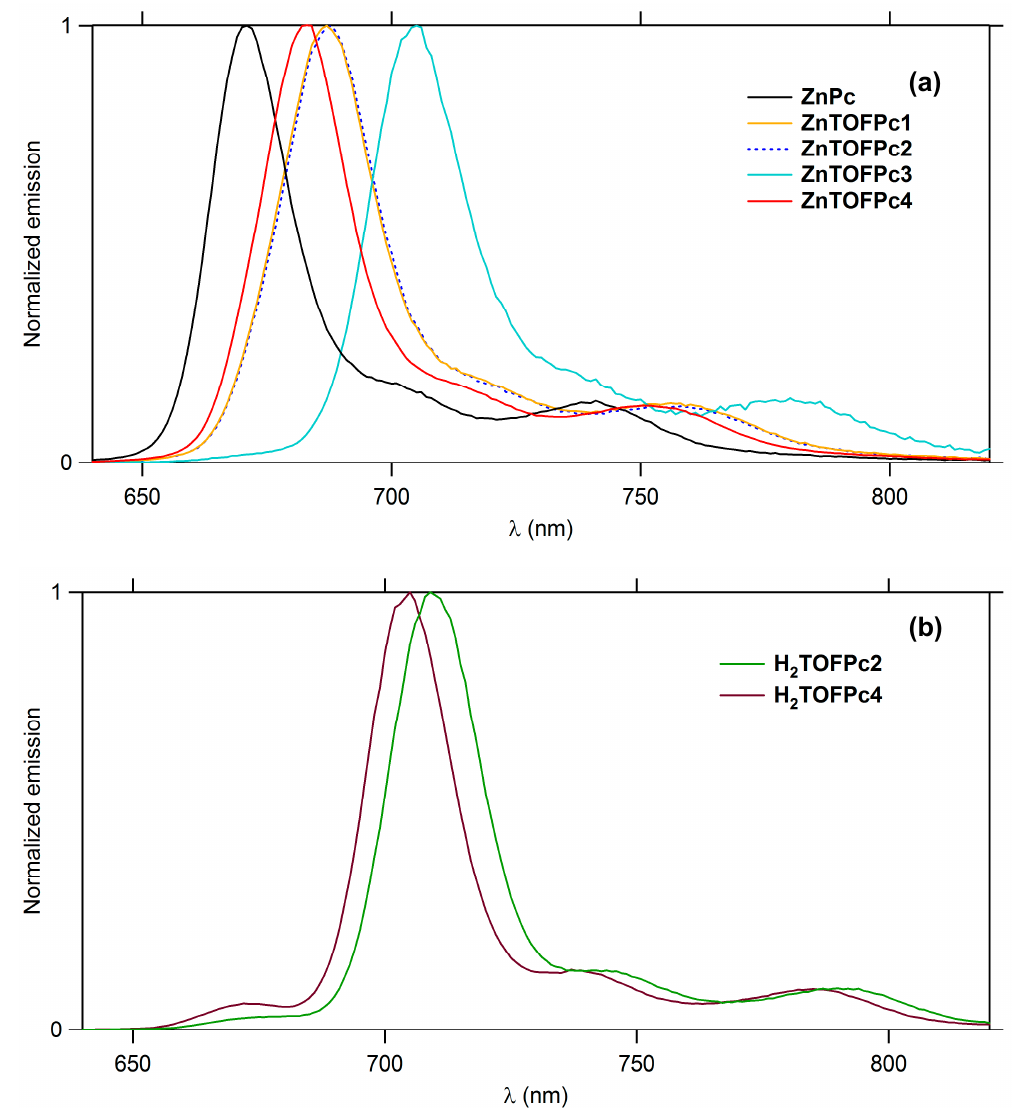
Figure 8. Emission spectra of the various phthalocyanine derivatives in THF at 20 °C (excitation at 606 nm): ( a ) ZnTOFPc1 – 4 and ZnPc used as reference; ( b ) H 2 TOFPc2 and H 2 TOFPc4 .